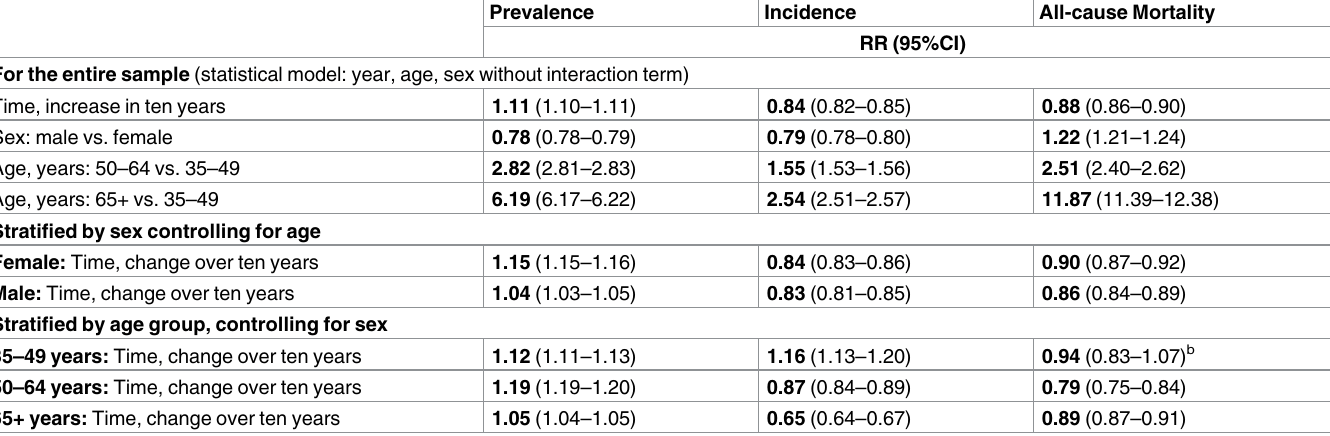
Table 1. Trends in concurrent physician-diagnosed asthma and COPD prevalence, incidence and mortality over time (increasewith calendar year) adjusted for sex and age in generalized linear model. Prevalence Incidence All-cause Mortality RR